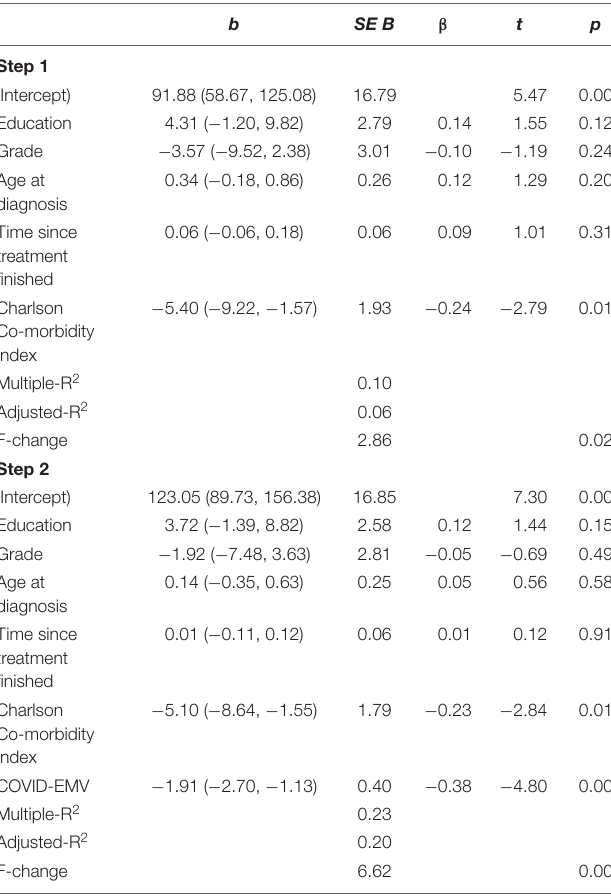
TABLE 5 | Hierarchical regression analyses for the predictors of perceived cognitive